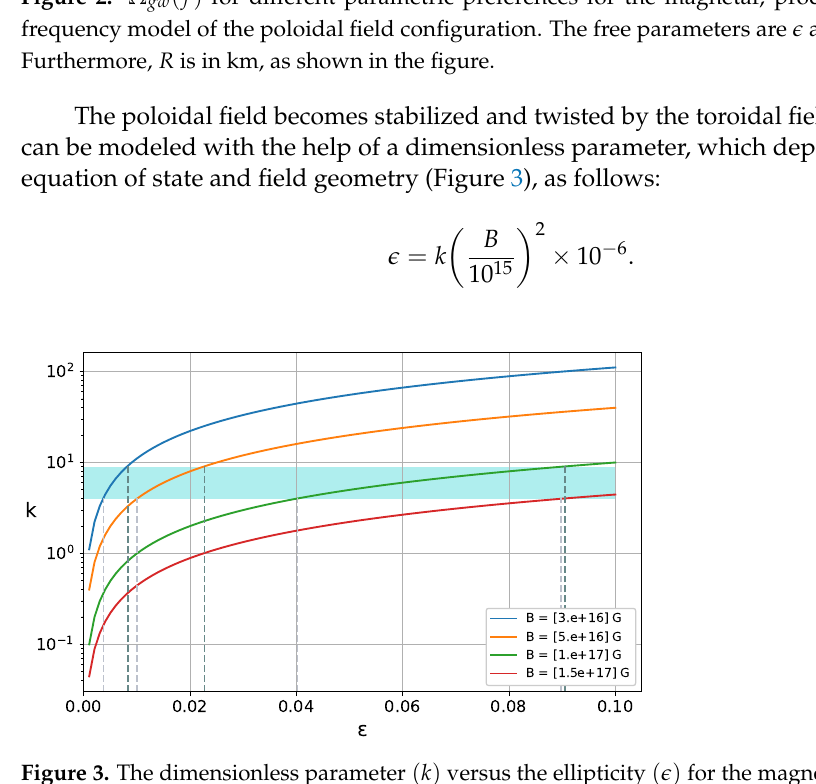
Figure 3. The dimensionless parameter ( k ) versus the ellipticity ( (cid:101) ) for the magnetars with different strengths. The only free parameter here is magnetic field ( B ) , same as in Figure 1. The parametric values are shown in the figure. The range of (cid:101) for being a realistic stellar model for each strength is marked by dashed